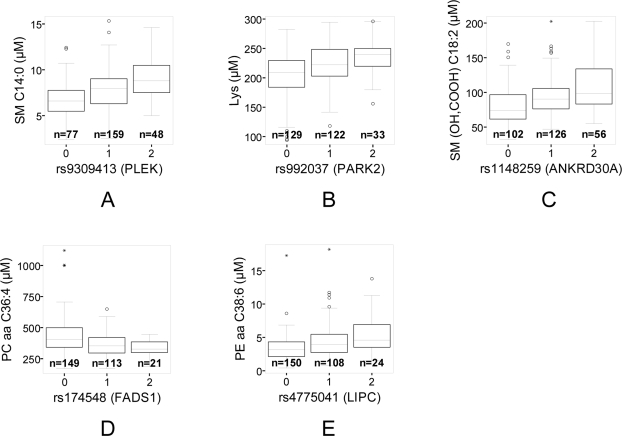
Boxplots of the metabolite concentrations of five top ranking associations as a function of genotype.They show the differentiation of the population that is induced by these genetically determined metabotypes (0 = major allele homozygote, 1 = heterozygote, 2 = minor allele homozygote). Boxes extend from 1st quartile (Q1) to 3rd quartile (Q3); median is indicated as a horizontal line; whiskers are drawn to the observation that is closest to, but not more than, a distance of 1.5(Q3-Q1) from the end of the box. Observations that are more distant than this are shown individually on the plot. The number of individuals in each group is given below the boxes. P-values for these associations are given in Table 1.